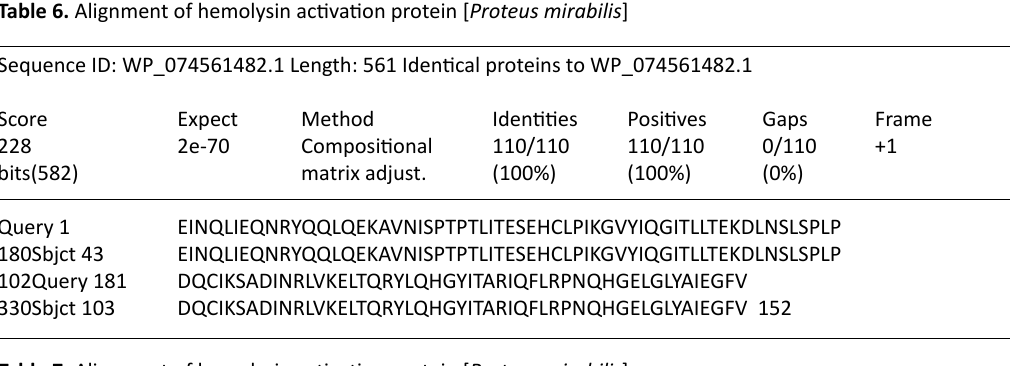
table 7. Alignment of hemolysin activation protein [ Proteus mirabilis ]